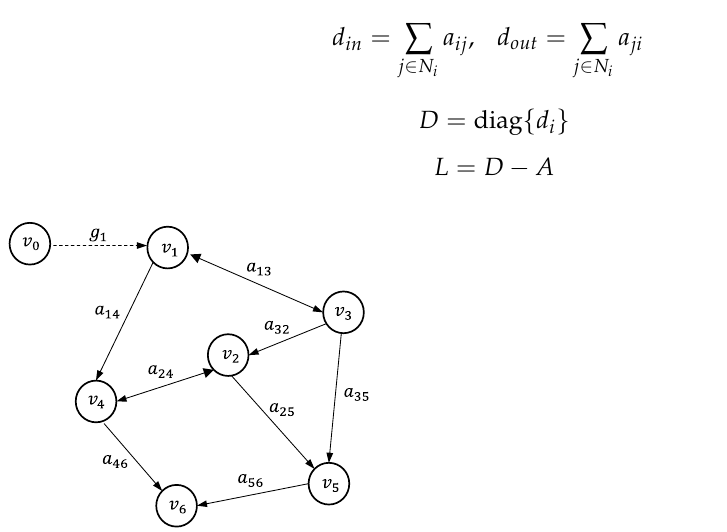
Figure 1. A directed graph of 6 agents.